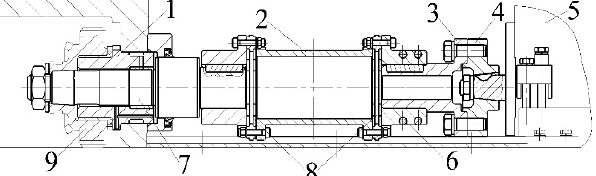
Figure 11. General view of the modernized design of the HPFP drive: 1—axle box; 2—spacer; 3—drive flange; 4—injection pump flange; 5—high-pressure fuel pump; 6—hub; 7—drive shaft; 8—plate clutch; 9—drive gear.